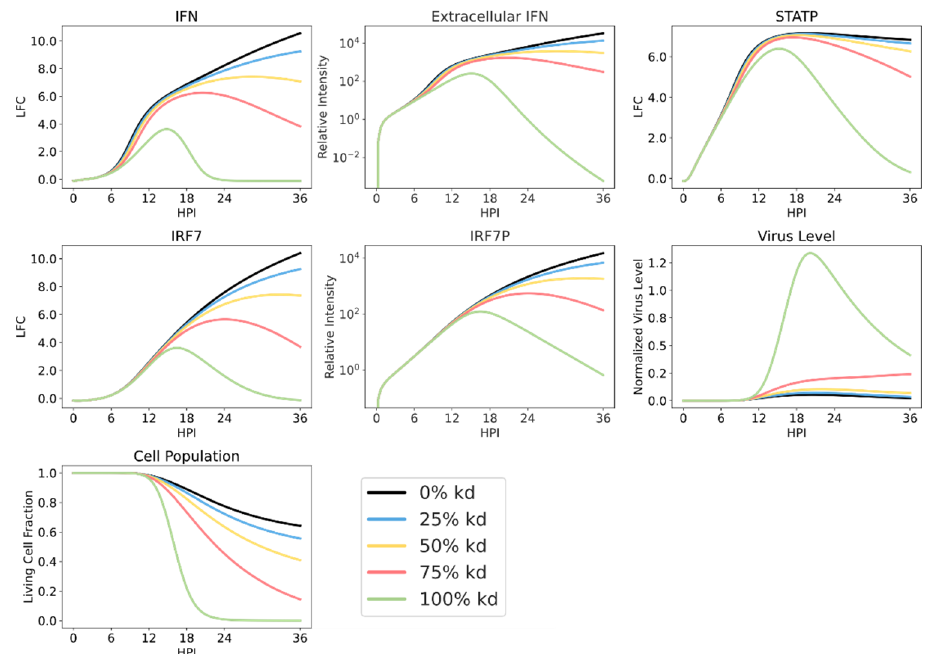
Figure 8. Simulations at varying levels of RIG-I knockdown (% knockdown or % kd of the k 11 parameter). Here, 0% knockdown means zero NS1 antagonism, matching the dNS1PR8 strain results. Moreover, 100% kd is equivalent to total antagonism via NS1, matching the wild-type PR8 results.